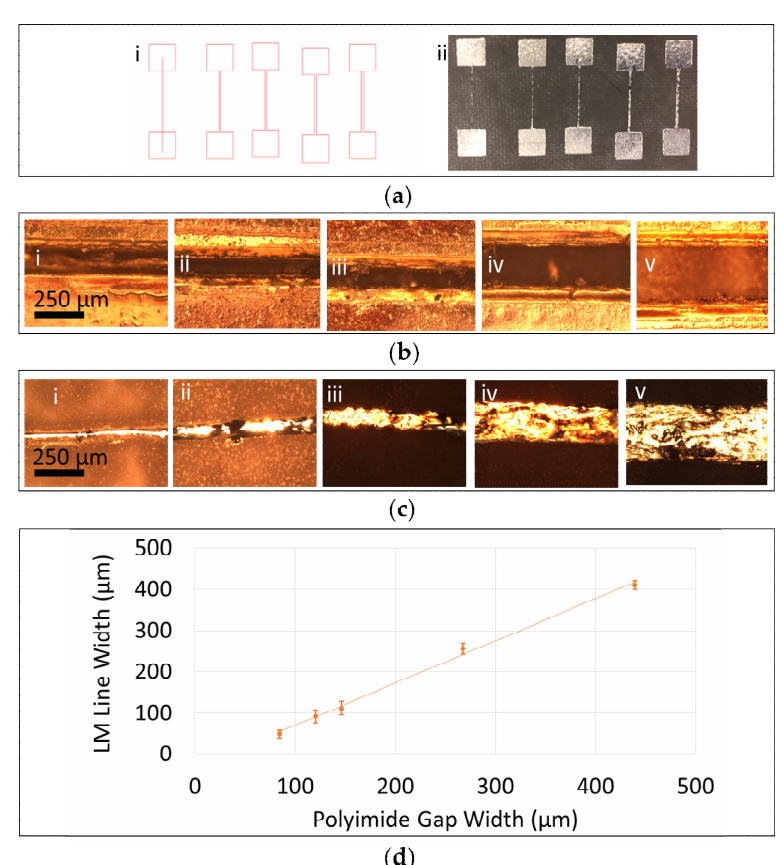
Figure 9. Measurement of sprayed LM line width. ( a.i ) Polyimide mask layout. ( a.ii ) Sprayed LM after removing the polyimide mask. ( b ) Images of the polyimide mask, with the cut gaps running through the center of the photos. ( c ) Images of the sprayed LM lines. ( d ) Measured LM line width vs. the width of the gap in the polyimide mask.